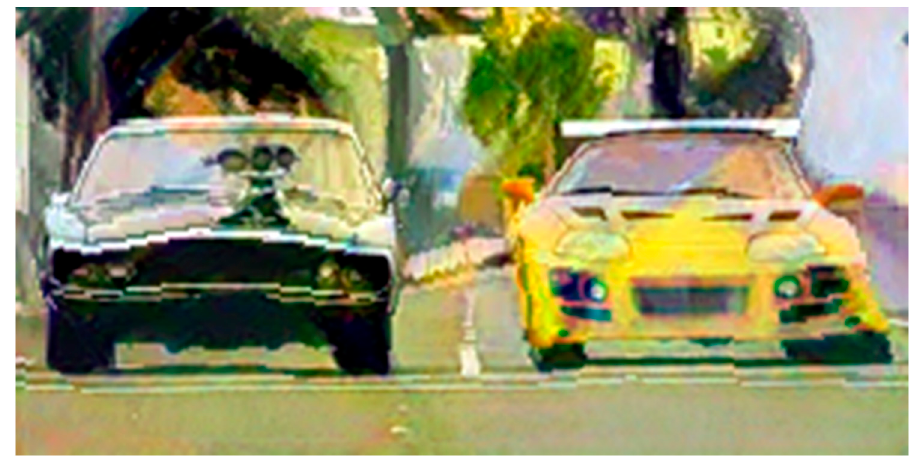
Figure 7. Results using the DST method.